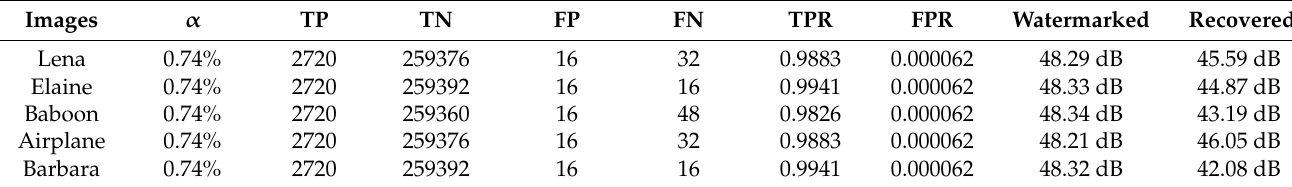
Table 2. Tamper localization and recovery analysis against cutting attack 2.